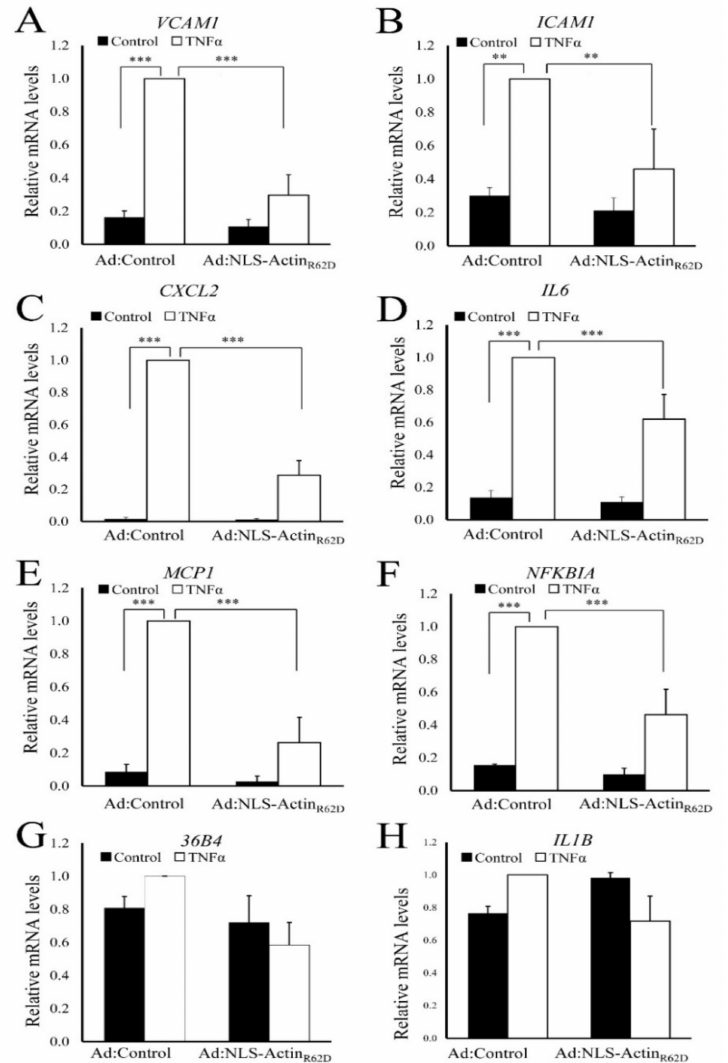
Figure 4. Nuclear actin monomer inhibits mRNA levels of NF- κ B target genes. VSMC were infected with either control adenovirus (Ad:Control) or an adenovirus expressing NLS-Actin R62D (Ad:NLS- Actin R62D ). The next day, cells were stimulated with 10 ng/mL TNF α for 2 h. Total RNA was extracted and analysed for mRNA levels of VCAM1 ( A ), ICAM1 ( B ), CXCL2 ( C ), IL6 ( D ), MCP1 ( E ), NFKBIA ( F ), 36B4 ( G ), IL1B ( H ) using RT-qPCR. Data are n = 5. One way ANOVA with Student Newman Keuls post-test; ** indicates p < 0.01, *** indicates p <